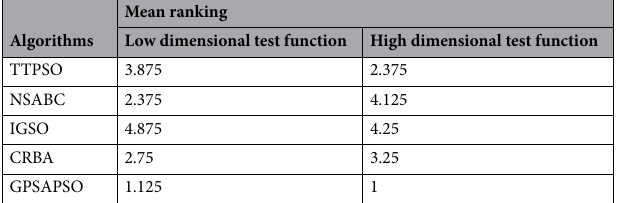
Table 5. Mean ranking values of different